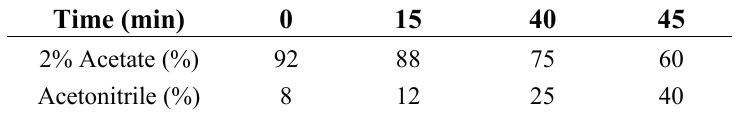
Table 1. Proanthocyanidins B 2 samples separated using gradient elution